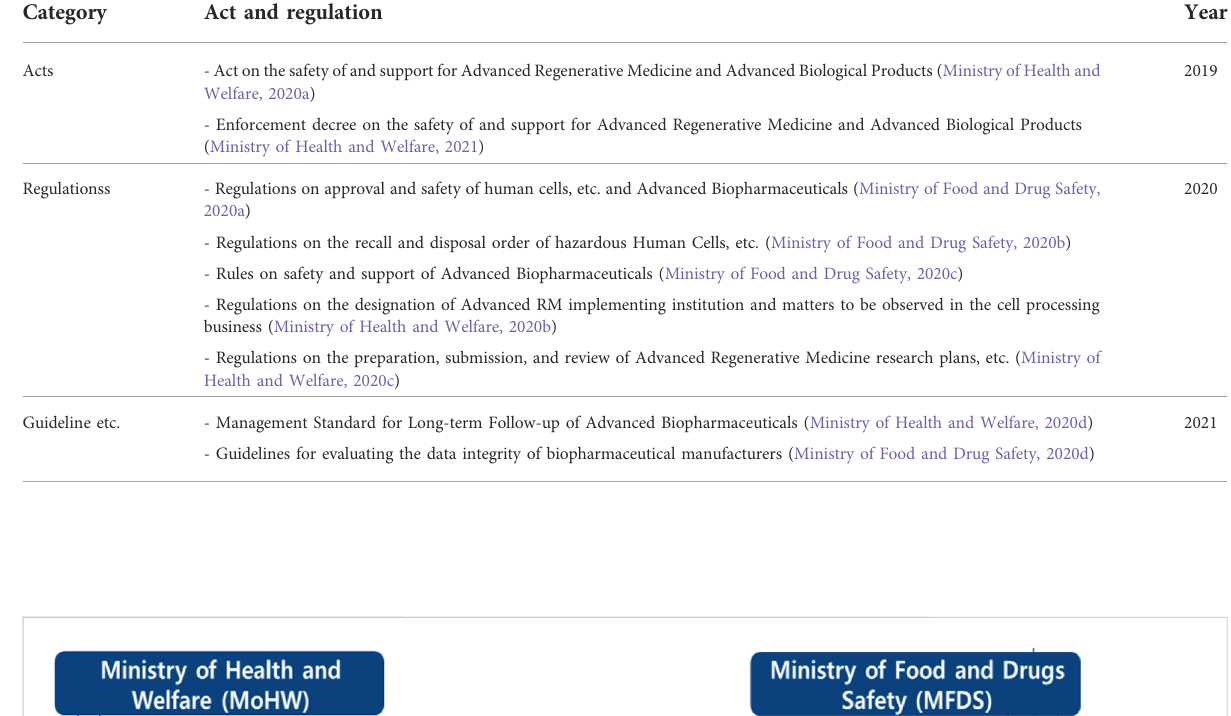
TABLE 1 Regulations on cellular treatment in South Korea.